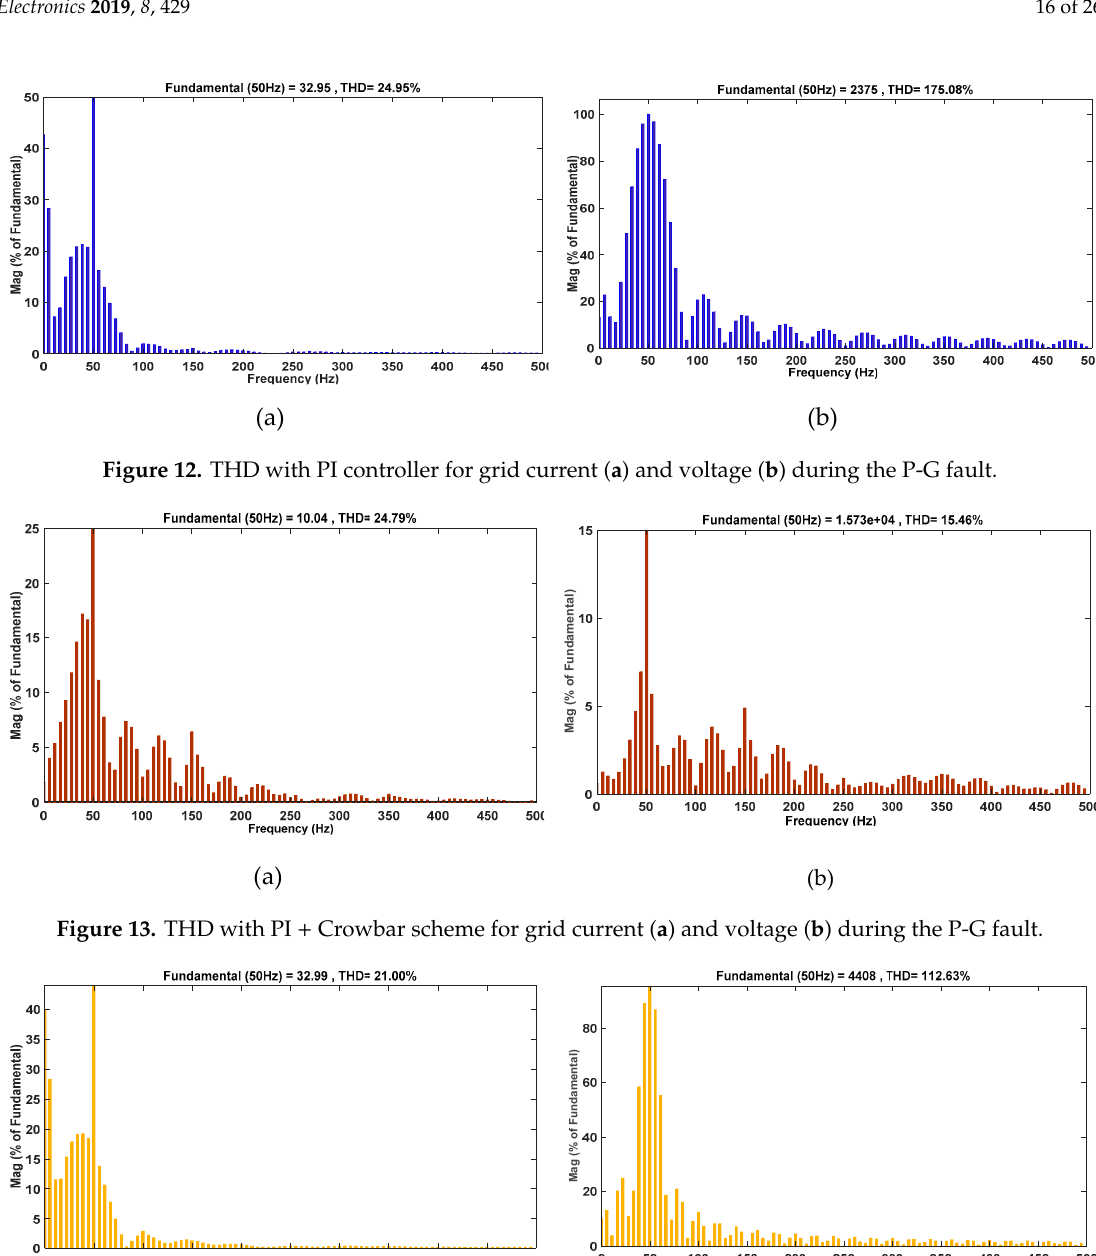
15 of 24 Figure 11. Grid currents and voltage during P-G 11 ( a, b ) and P-P 11 ( c, d ), respectively. Furthermore, total harmonic distortion (THD) is calculated with fast Fourier transform (FFT) analysis for grid current and voltage during the P-G fault. The distortion in harmonics is carried out under analysis for a proposed approach (LM+BFCL) and for other possible combinations i.e., from Figure 12 to Figure 17. The proposed approach gives minimum values of THD for current and voltage i.e., 16.24% and 9.20%, respectively, as depicted by Figure 17. However, for the conventionally adopted PI + Crowbar strategy, the THD values 24.79% and 15.46% for the current and voltage are depicted in Figure 13. However, considering the THD response of controllers without FRT strategy i.e., for PI and FLC based on LM optimization. The LM optimization-based control have 21% and 112.63% THD for current and voltage, respectively. However, the conventional PI controller results in 24.95% and 175.08% for current and voltage, respectively, as shown by Figure 12 and Figure 13. Therefore, the